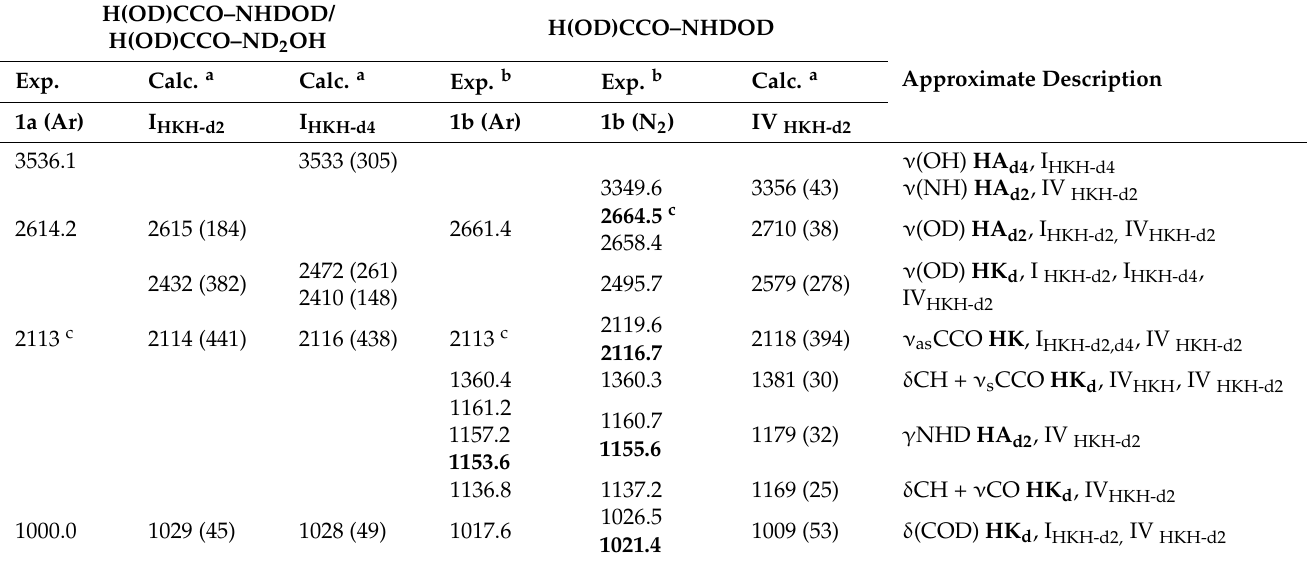
Table 3. Comparison of the observed and calculated anharmonic wavenumbers (cm − 1 ) for